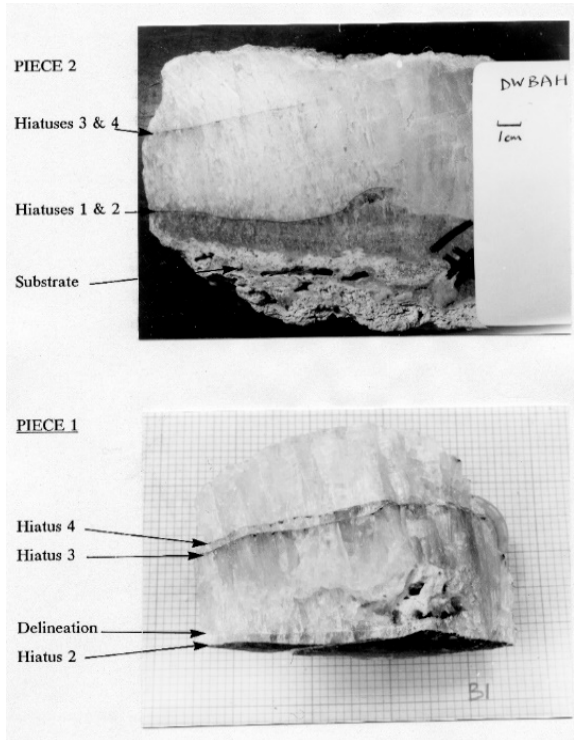
Figure 10. The DWBAH flowstone, sampled at − 15 m on the Grand Bahama Island (courtesy of Joyce Lundberg).